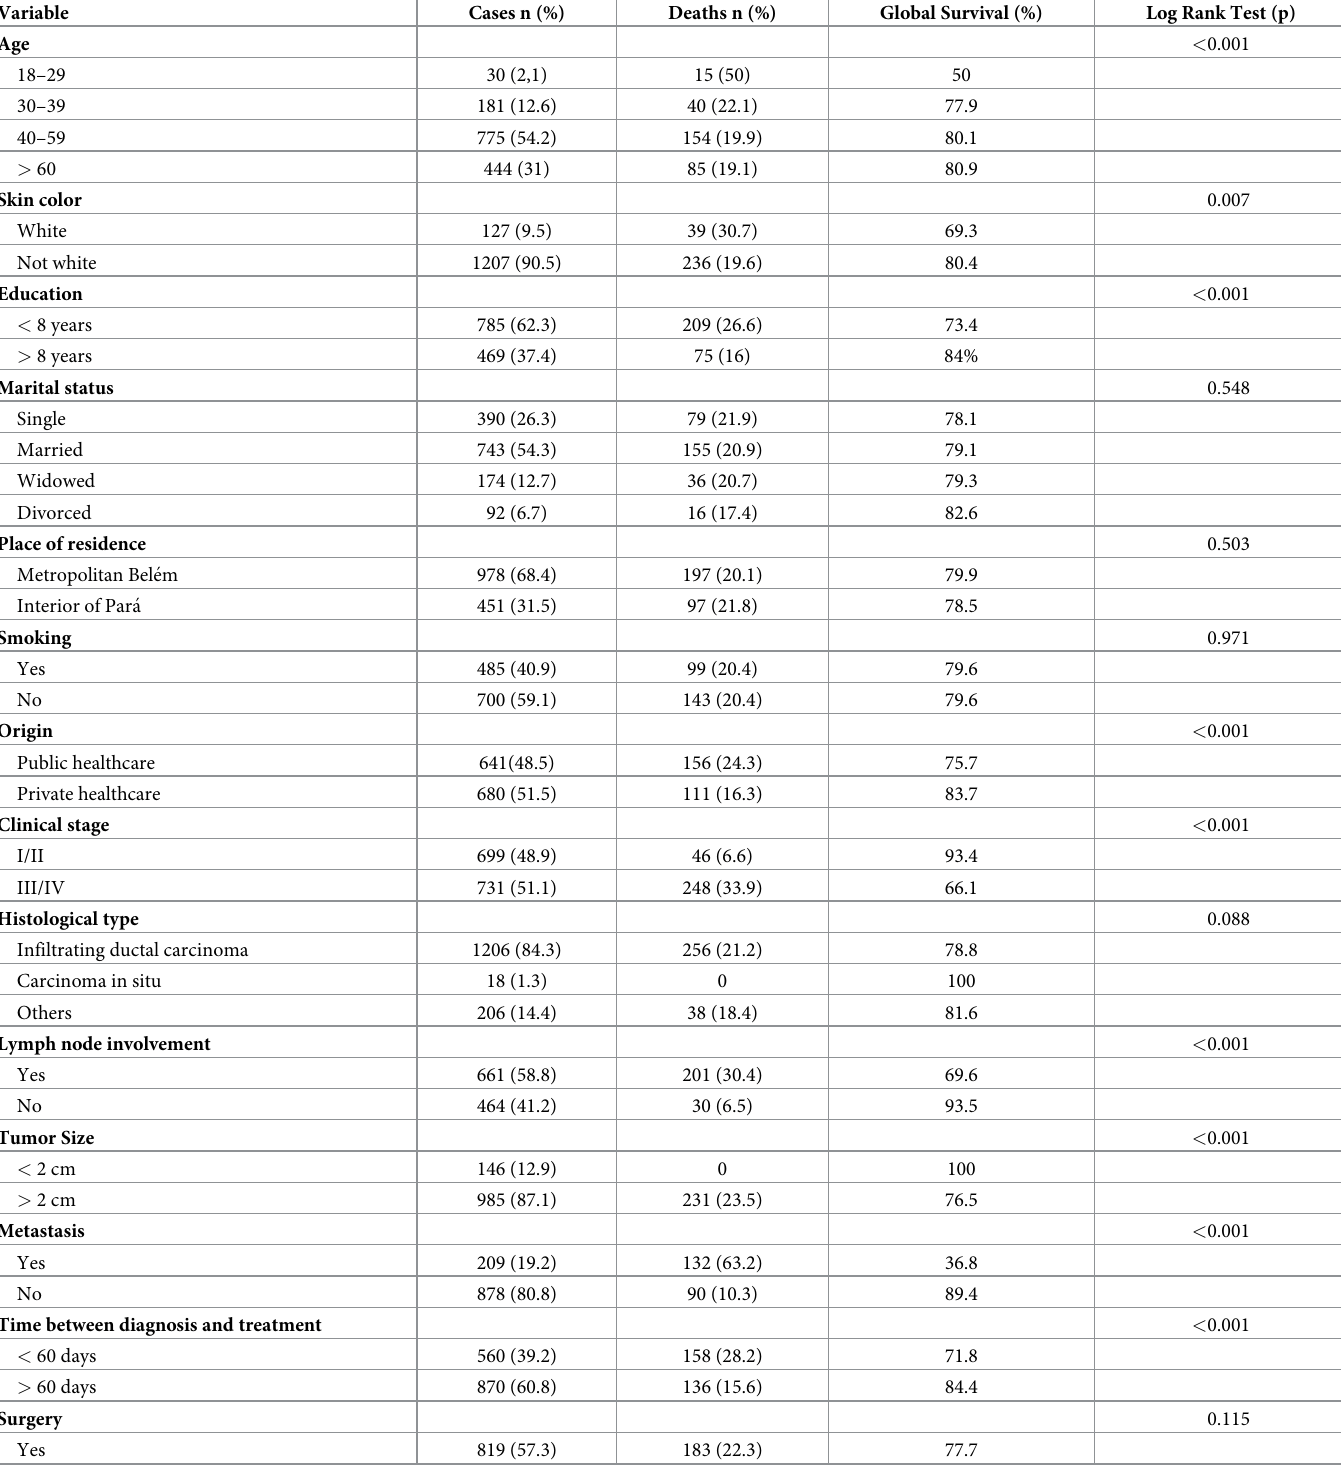
Table 2. Distribution of sociodemographic, clinical and treatment characteristics and survival analysis in women treated for breast cancer. Bele´m, Para´, Brazil,